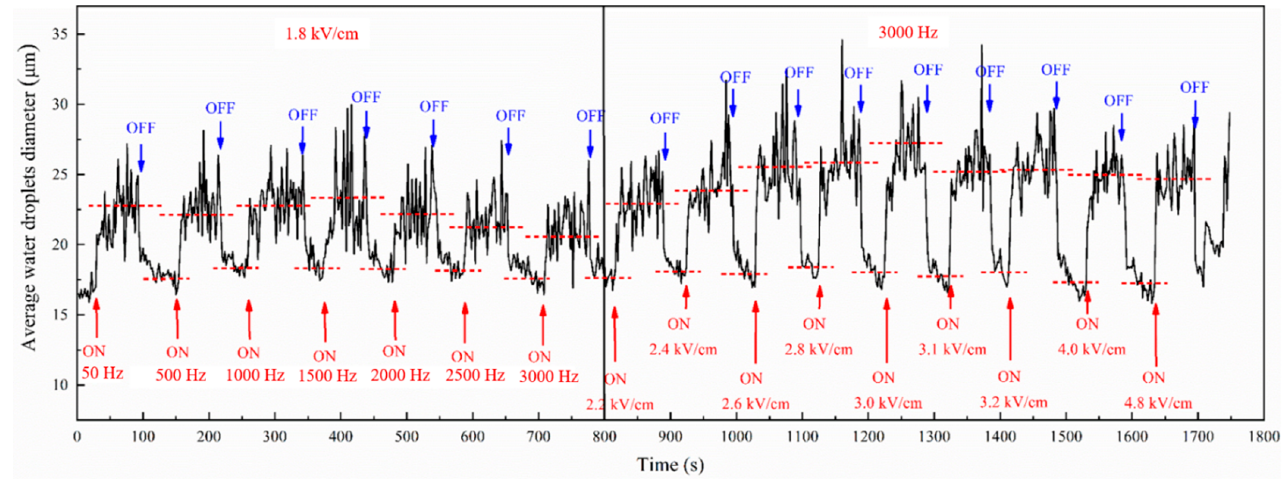
Figure 13. Variations of average water droplet size under different electric field parameters.